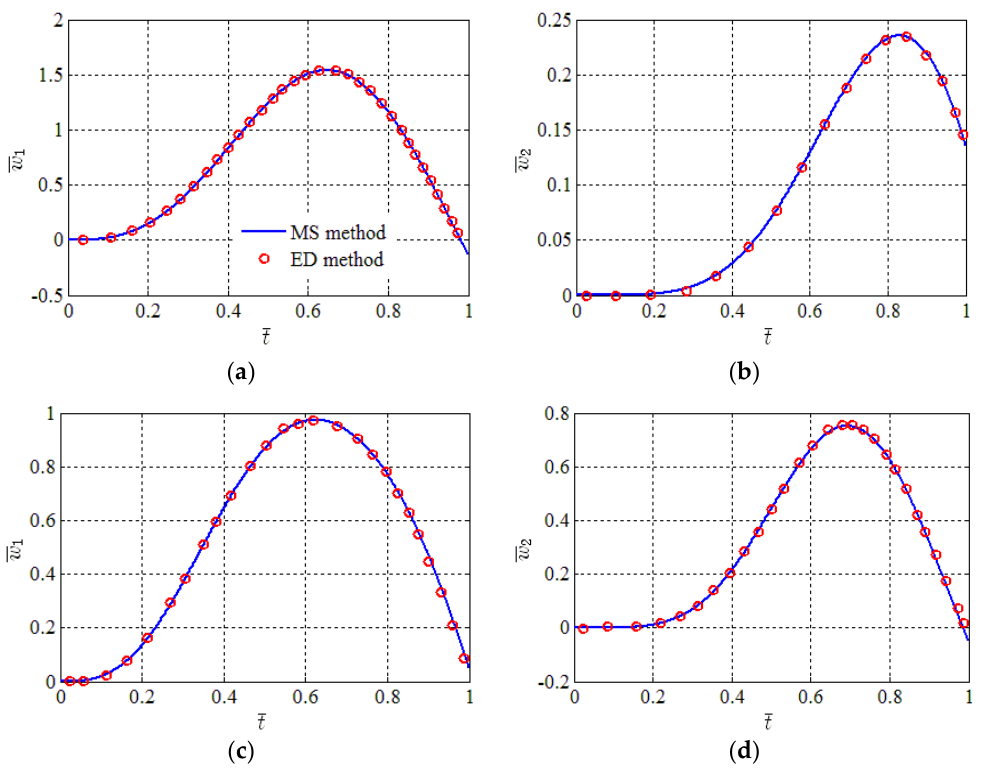
Figure 13. Comparison between the results from the Modal Superposition (MS) method in this study and the results from the Equation Decoupled (ED) method by Hilal [19] for α = 0.5 , ( a , b ) s e = 10 , ( c , d ) s e = 100 .